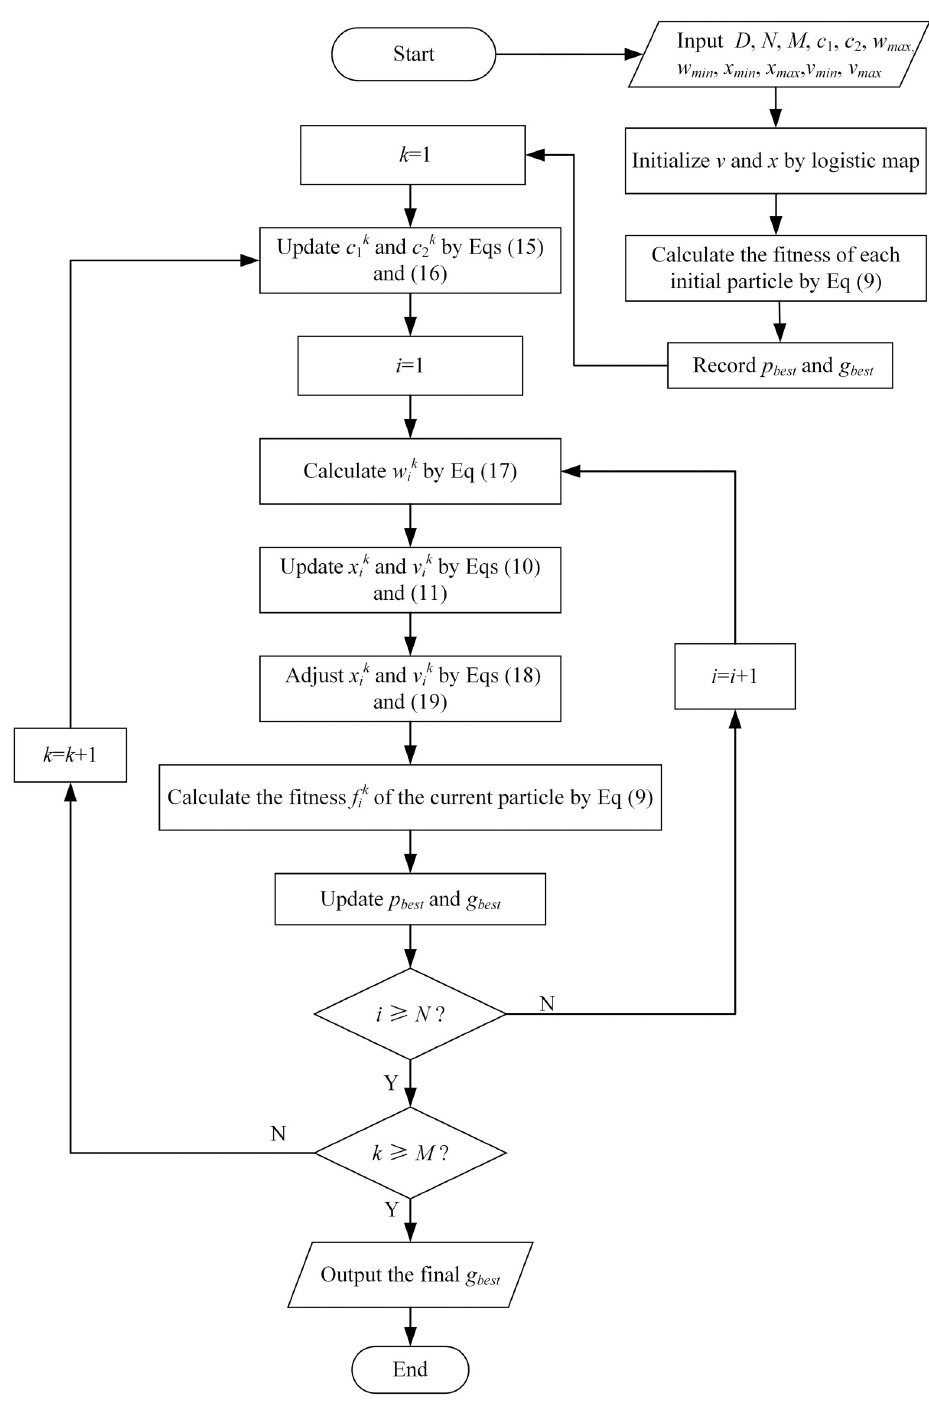
Fig 1. Flow chart of the MPSO